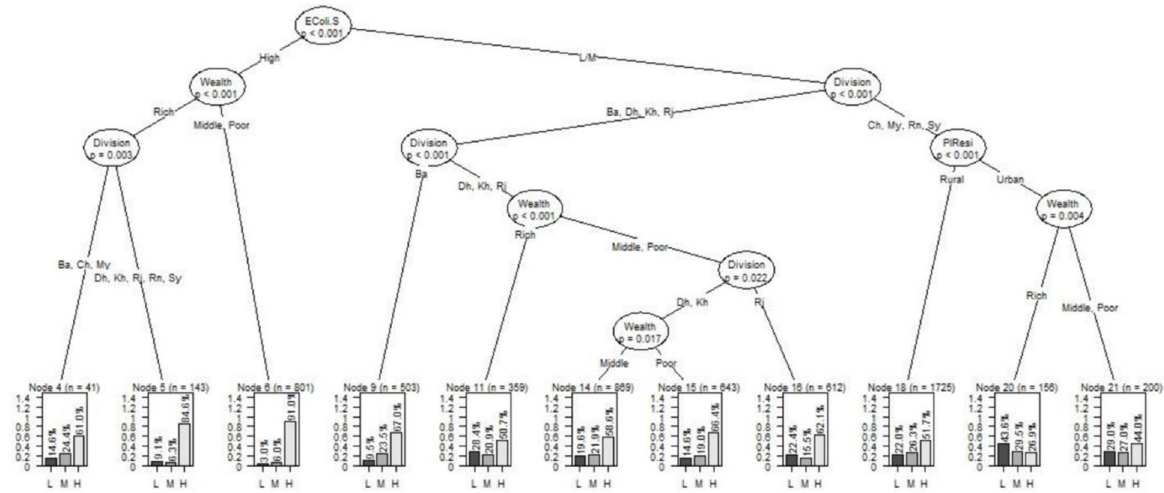
Fig 1. Classification tree representing the distribution of levels of E . coli contamination of drinking water across different combinations of the levels of household characteristics.